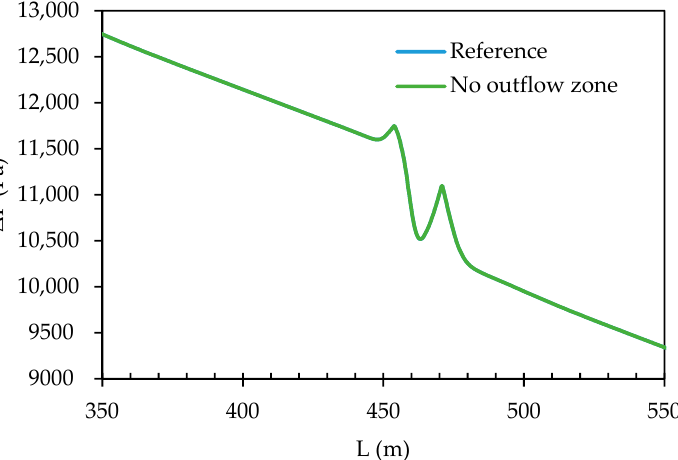
Figure 7. Development of TMP along the spacer flow path centreline for the 1,500,000 cell grid with an outflow zone (reference) and without an outflow zone.